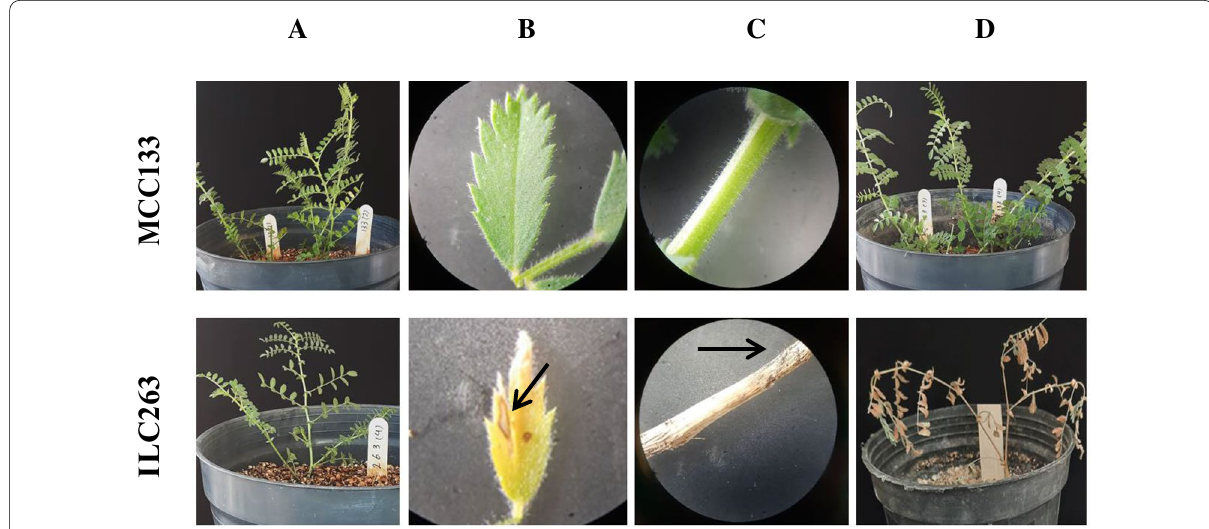
Fig. 1 The damage of Ascochyta rabiei Pathotype III on ILC263 (sensitive) and MCC133 (resistant) chickpea lines. A (Plants just before inoculation), B and C (Disease symptoms on the leaves and stems 15 days after inoculation with 10 inoculation). The arrows are shown the disease symptoms on the inoculated leaves and